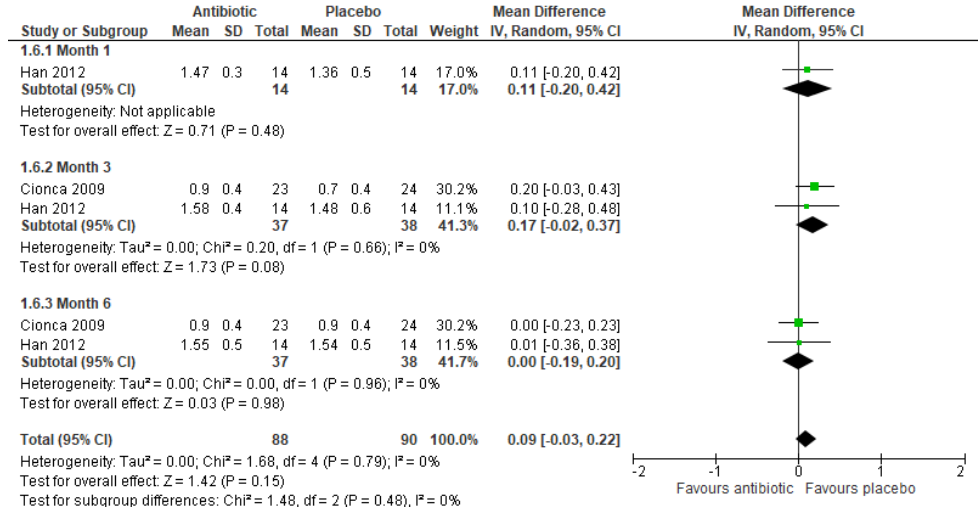
Figure 6. Meta-analysis of reduction in mean clinical attachment level (mm) after three months for studies assessing mechanical debridement with antibiotics in the treatment of periodontitis.